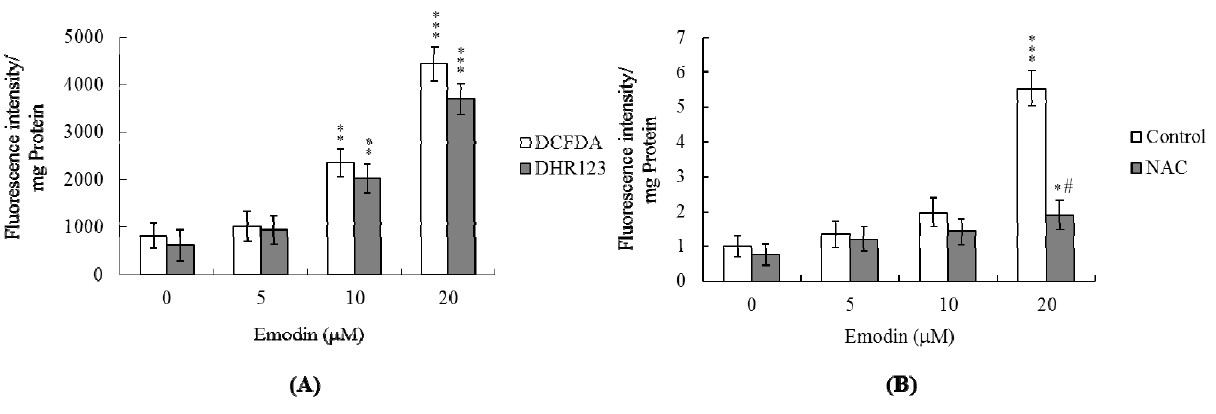
Figure 2. Emodin promotes oxidative stress in IMR-32 cells. ( A ) IMR-32 cells were treated with 0–20 μ M emodin for 24 h, and ROS generation assayed using DCF-DA (20 μ M)